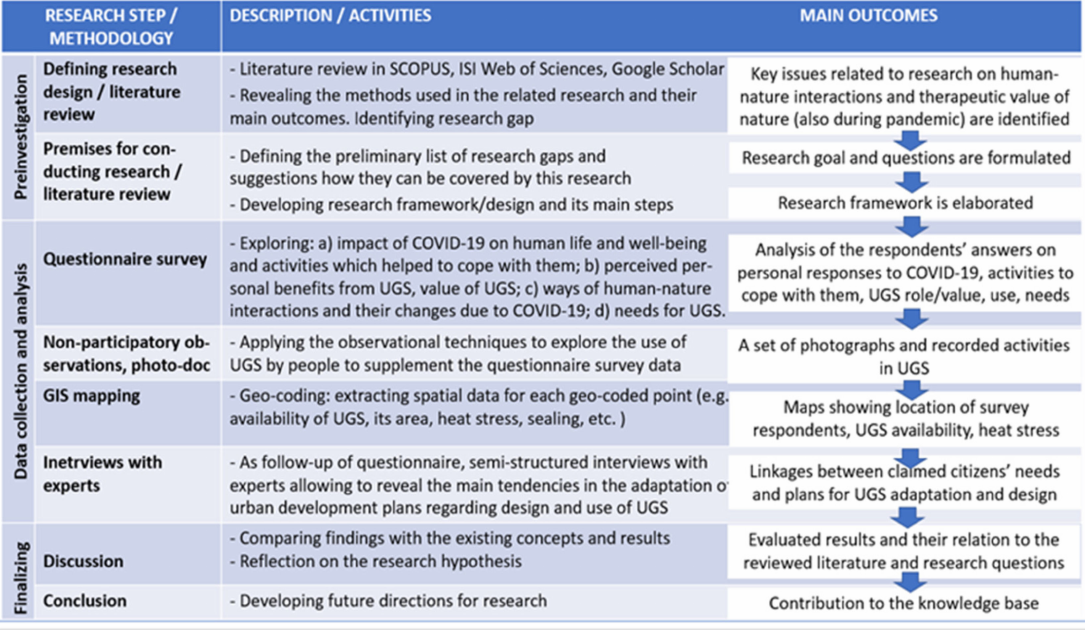
Figure 1. Research